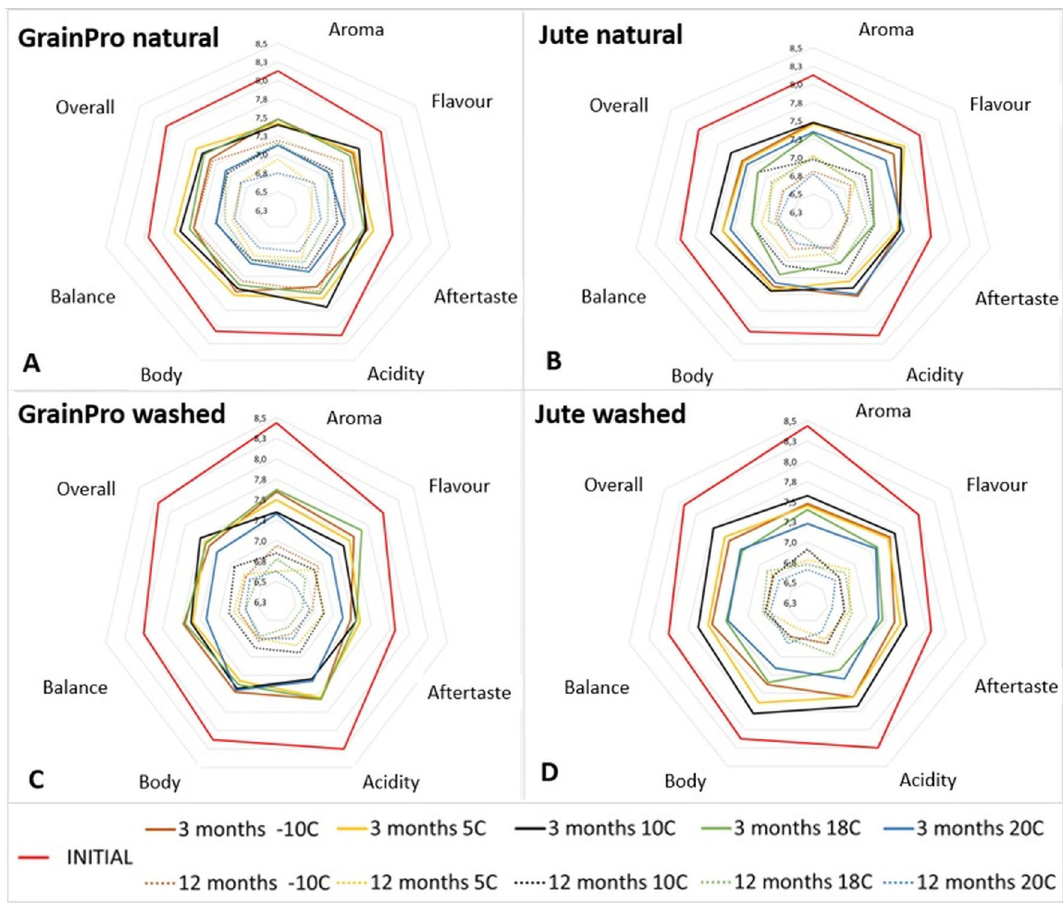
Figure 2. Sensory profiles of the roasted coffee samples: natural ( A , B ) and washed ( C , D ) processing and stored in GrainPro ( A , C ) and jute ( B , D ) bags after 3 and 6 months of storage compared to the initial values before storage. Mean values (n =